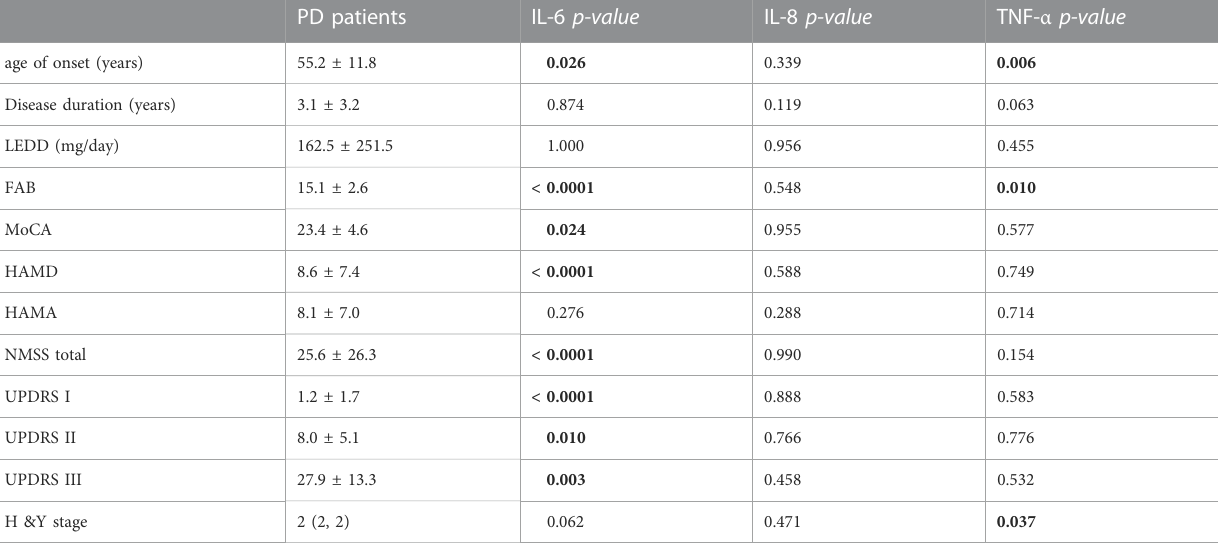
TABLE 2 Clinical characteristics of PD patients and the associations with in fl ammatory factor